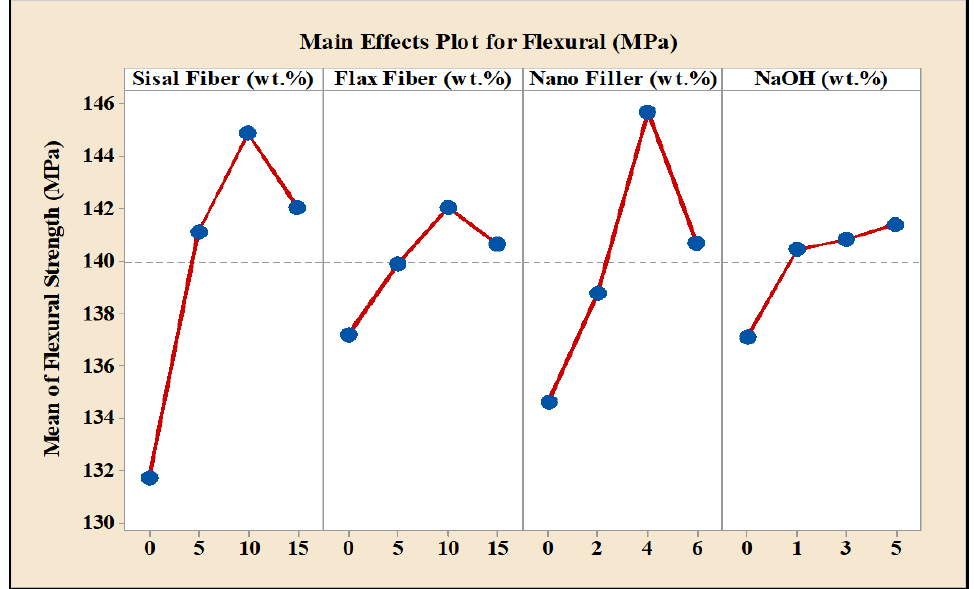
Figure 11. Mean Values of Bending Behaviour of Hybrid Composites with various input parameters.